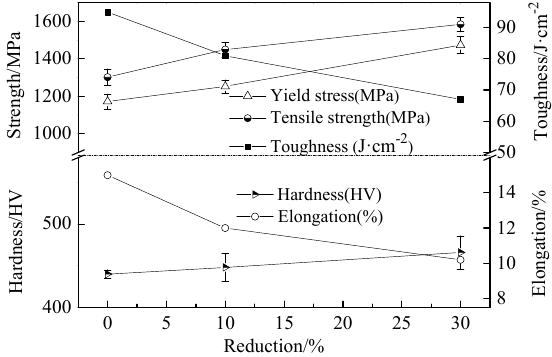
Figure 7. Mechanical properties of high-strength steel.